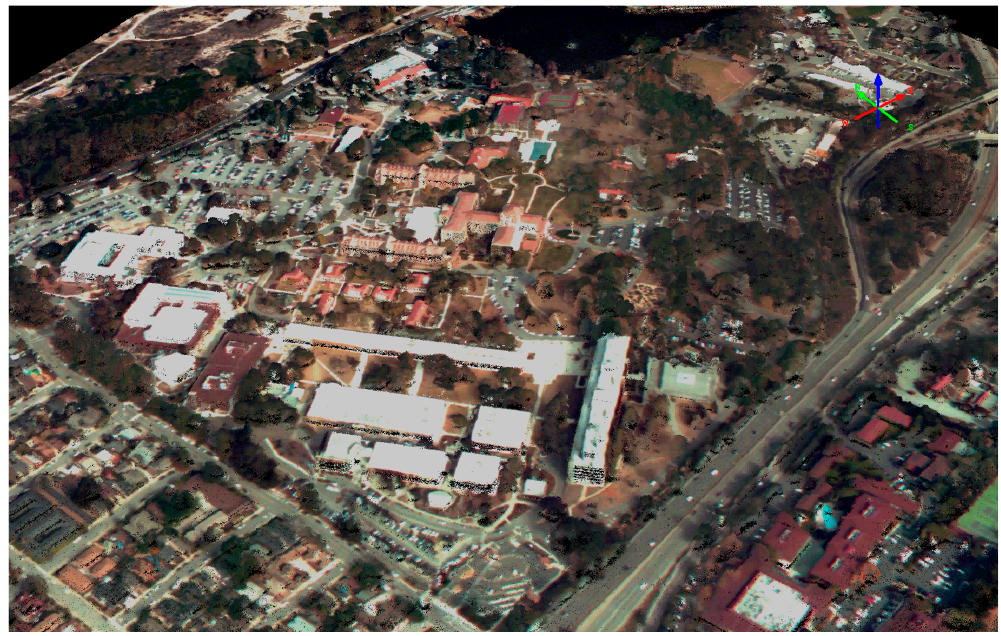
Figure 12. “Fused” HRQLS-1 lidar-photographic 3D image of the Naval Post Graduate School in Monterrey, California.